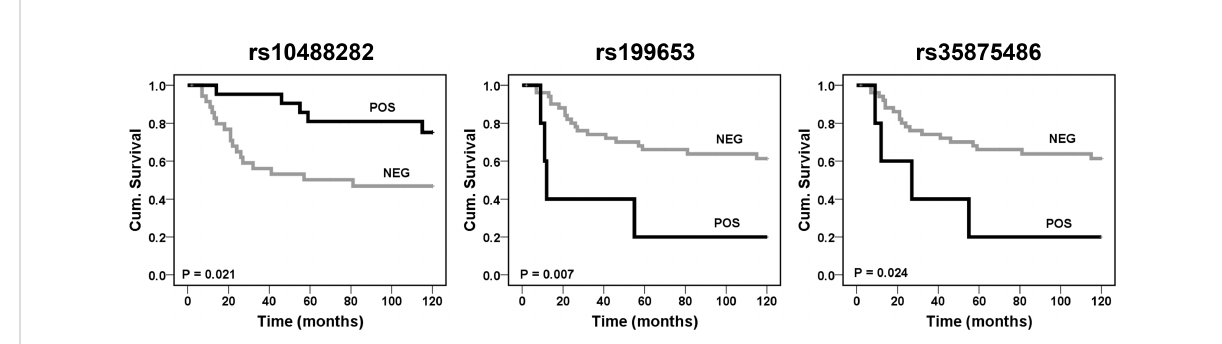
TABLE 5 Cox proportional-hazards regression multivariate analysis for IGF2BP3 SNPs associated with OVS after univariate analysis in the dataset of 58 EWS patients. Variant alleles associated with poor OVS HR 95% CI rs10488282-C: NEG